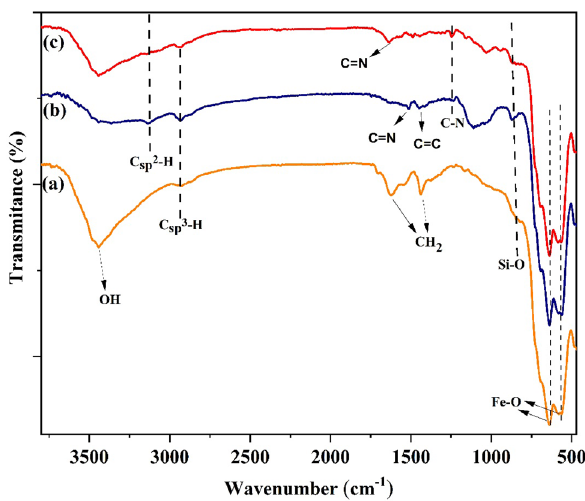
Figure 2. FT-IR spectra of ( a ) chloro-functionalized-γ-Fe 2 O 3 , ( b ) γ-Fe 2 O 3 -Im and ( c ) (γ-Fe 2 O 3 -Im-Py) 2 WO 4 .